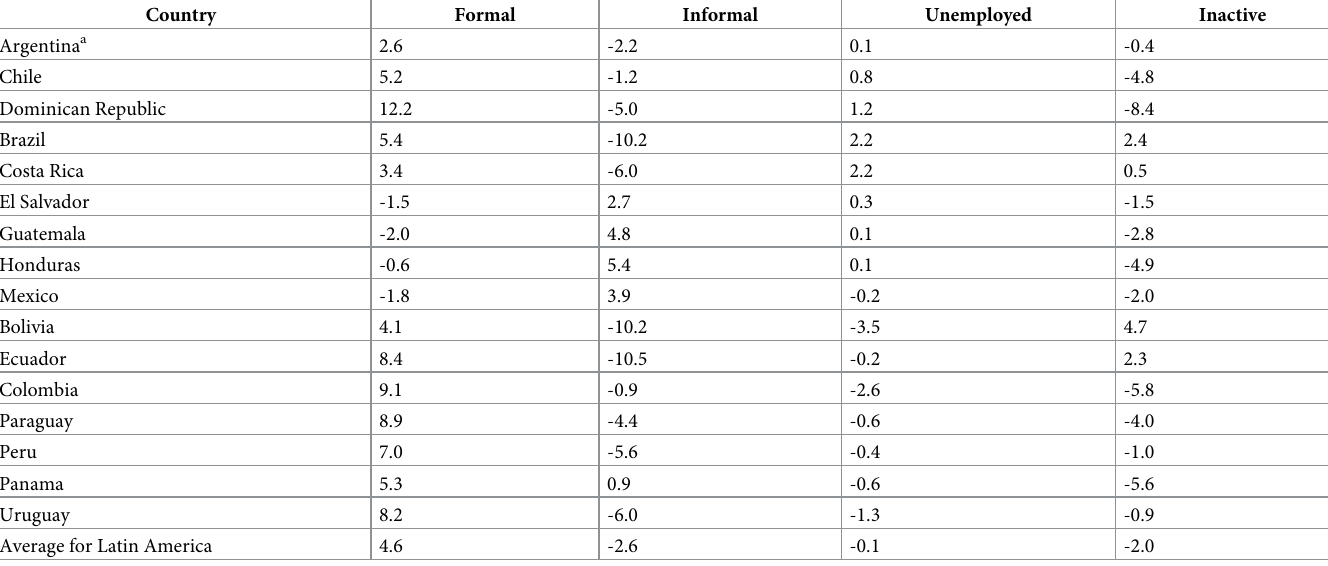
Table 1. Absolute change in the distribution of the working-age population in Latin America, 2006–-circa 2018 (percentage points).